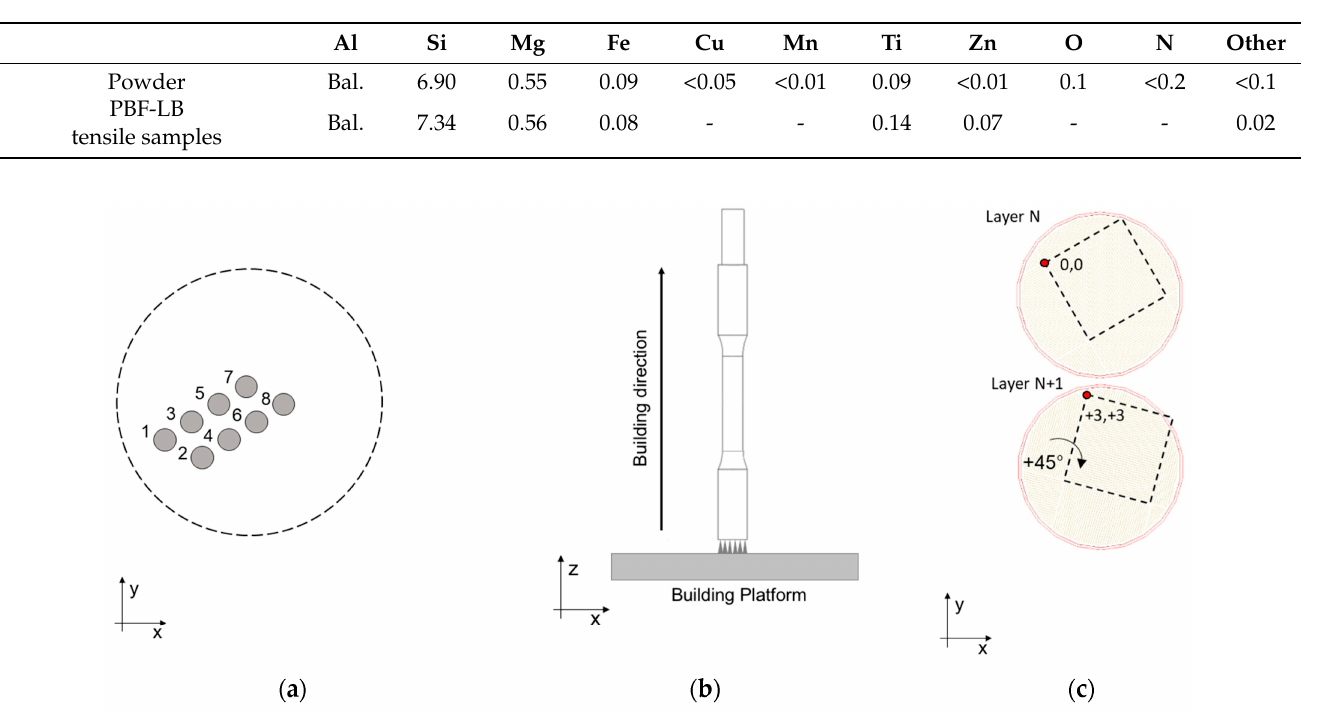
Table 1. The powder's chemical composition (wt.%), given by the supplier [29], and PBF-LB tensile samples were checked by GDOES.